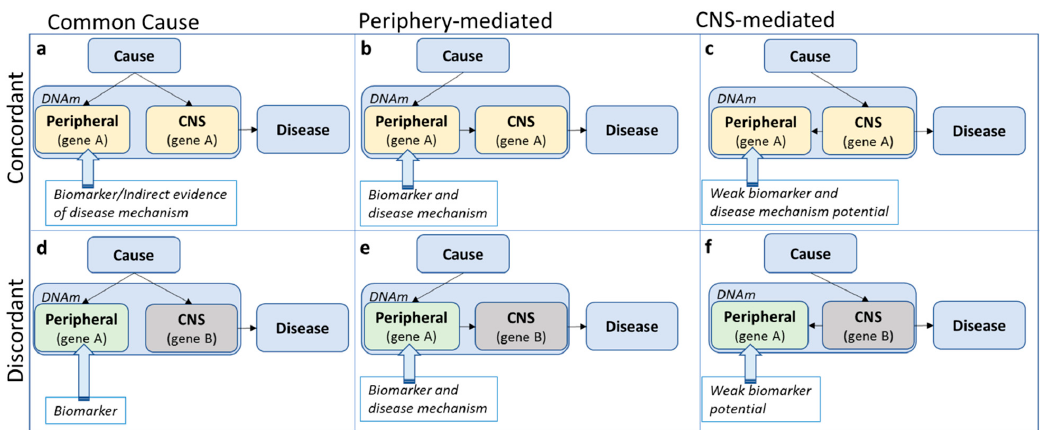
Figure 2. Three potential scenarios (by column) describing the relationship between peripheral and central nervous system (CNS) DNA methylation (DNAm) profiles within the pathway from cause to disease, assuming either consistency in effect of the risk exposure on DNA methylation across tissue (i.e., concordance; top panel) or discordance (bottom panel).